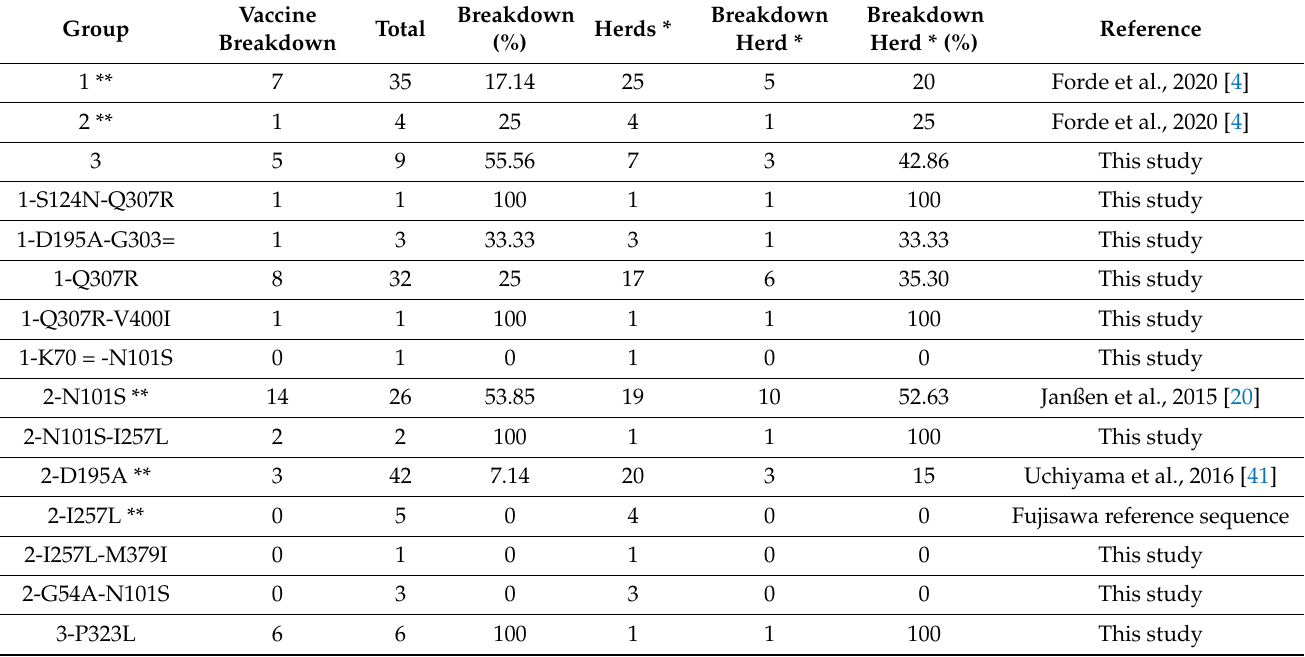
Table 1. Vaccine breakdown among Australian E. rhusiopathiae